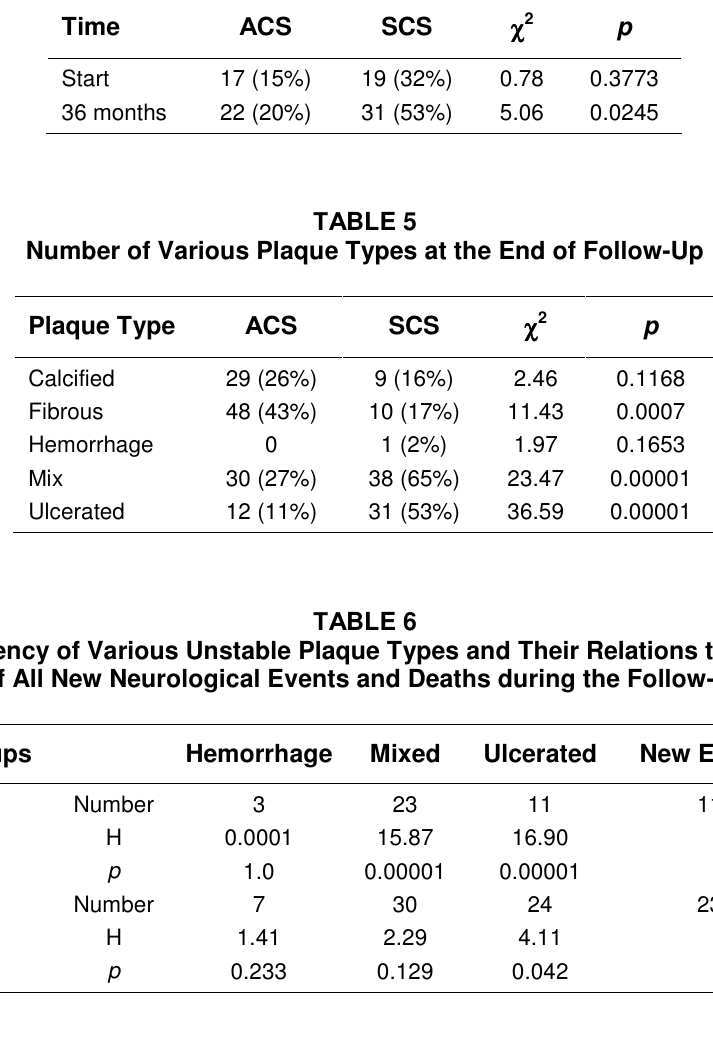
Contralateral CCA or ICA Occlusion at